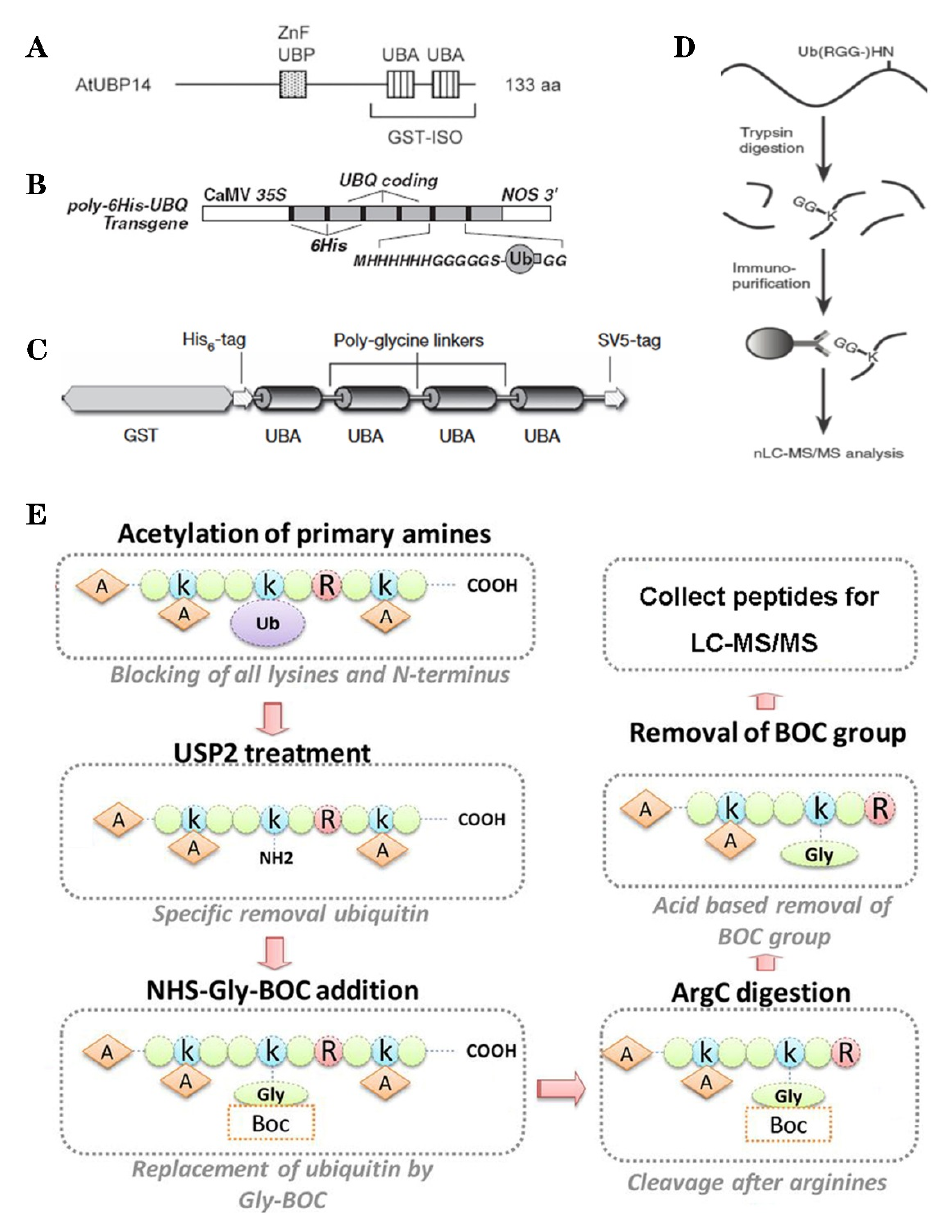
Figure 2. The classic methods of ubiquitylome in plant. ( A ), a single enrichment step approach using UBA (Ub-associated) motif [25]. ( B ), tandem a ffi nity purification (TAP) approach using poly His-tag-UBQ (Ub) motif [26]. ( C ), two-step a ffi nity tandem Ub-binding entities (TUBE) [33]. ( D ), A ffi nity chromatography using Lys- ε -Gly-Gly (K- ε -GG) specific antibody [29]. ( E ), the Ub COFRADIC (combined fractional diagonal chromatography) pipeline [34].